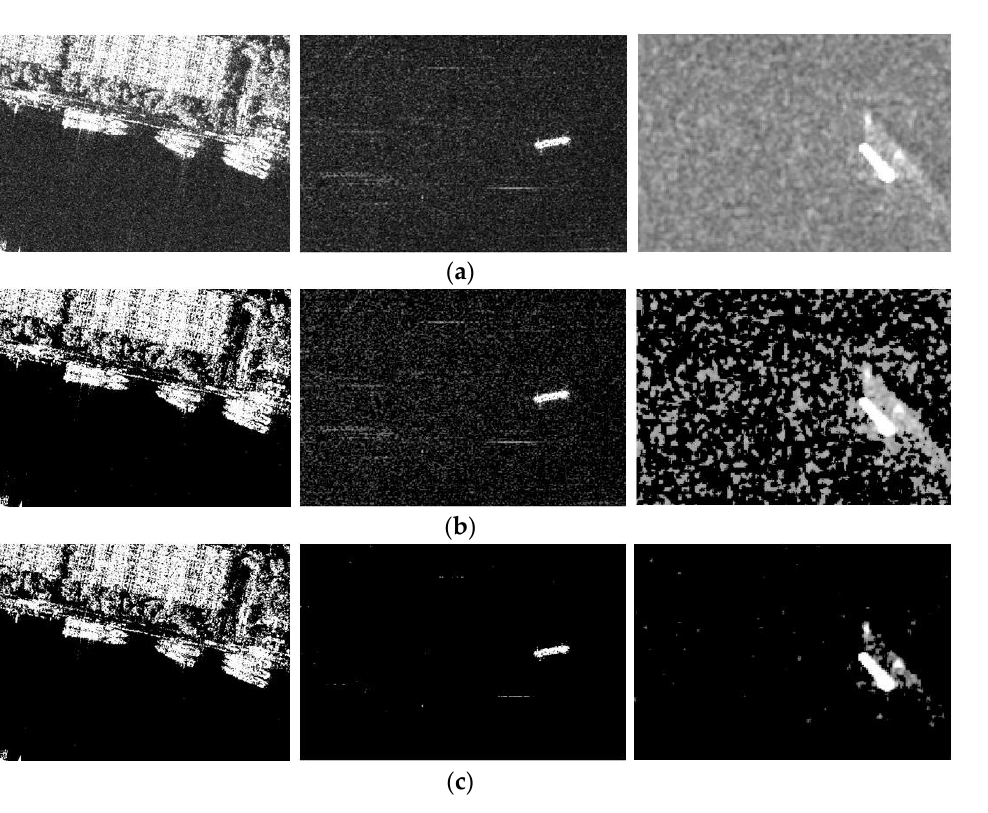
Figure 4. Segmentation effect of S-Otsu on SAR images in different scenarios: ( a ) Original SAR image; ( b ) Segmentation effect of Otsu on SAR images; ( c ) Segmentation effect of S-Otsu on SAR images.